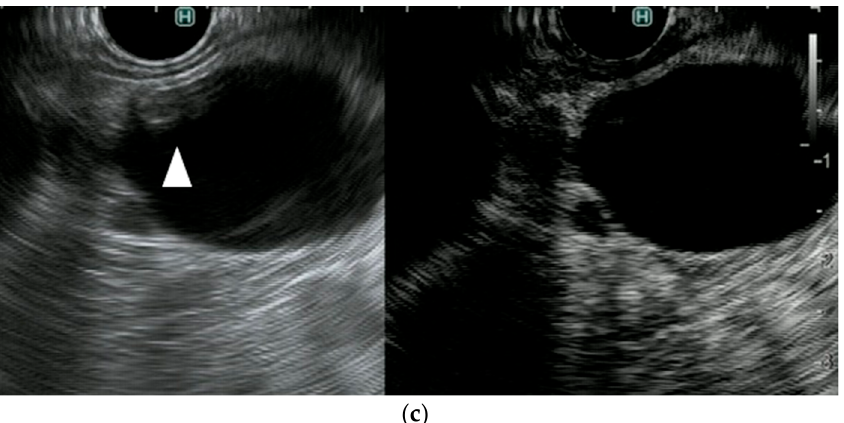
Figure 5. A representative case of a mucous clot in a patient with an intraductal papillary mucinous neoplasm (IPMN). ( a ) DFI endoscopic ultrasonography shows no vascularity in the mural lesion (arrow). ( b ) e-FLOW endoscopic ultrasonography shows no vascularity in the mural lesion (arrow). ( c ) Contrast-enhanced endoscopic ultrasonography shows no vascularity in the mural lesion (arrow).